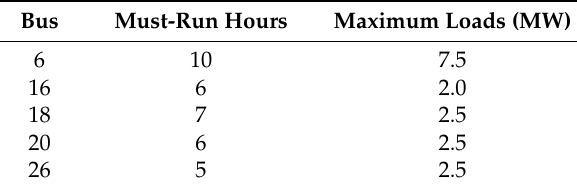
Table 4. Parameters of elastic